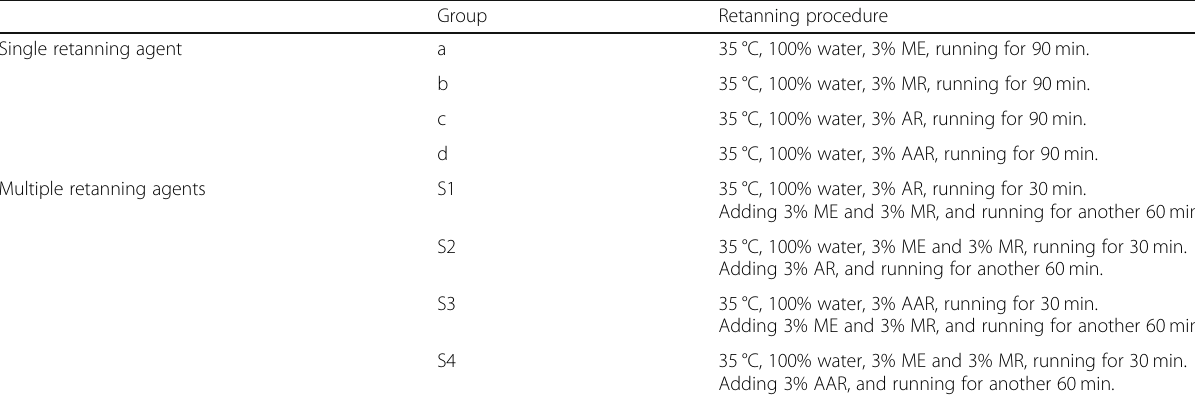
Group Retanning procedure